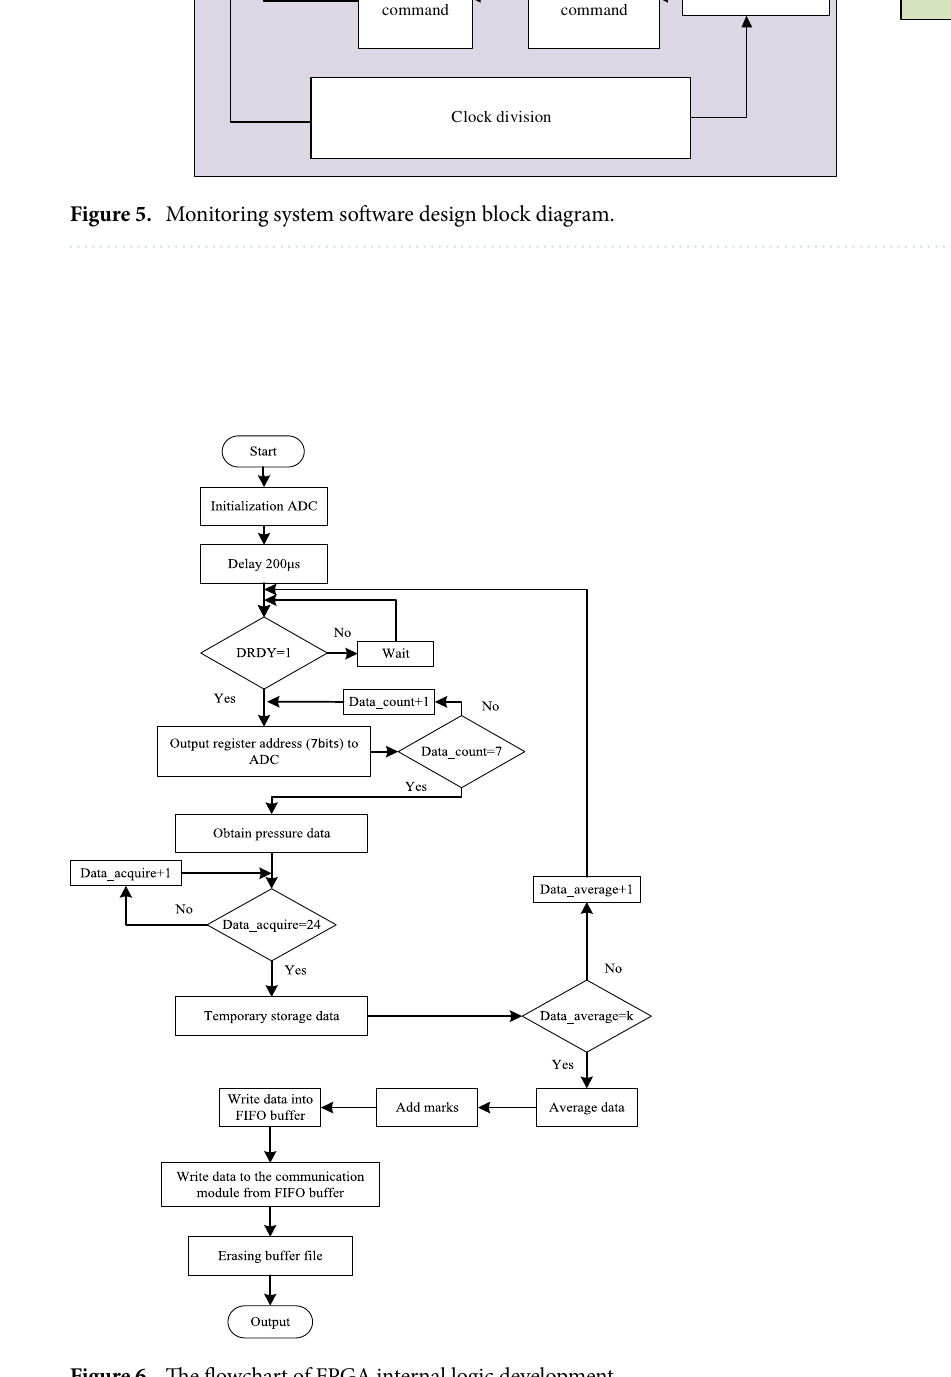
Figure 6. The flowchart of FPGA internal logic